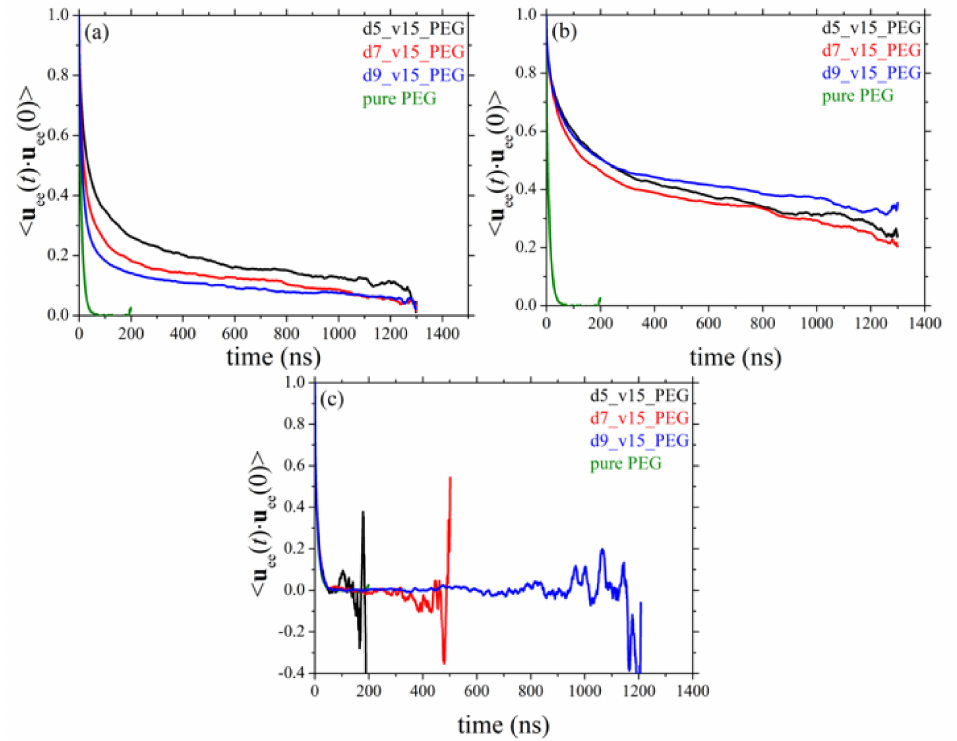
Figure 10. Decay of the ACF of the chain end-to-end unit vector in time ( T = 413 K and p = 1 atm) in systems 1–4 (dependence on silica size). The results refer to: ( a ) all chains, ( b ) only adsorbed chains, and ( c ) only free chains in the corresponding nanocomposites.